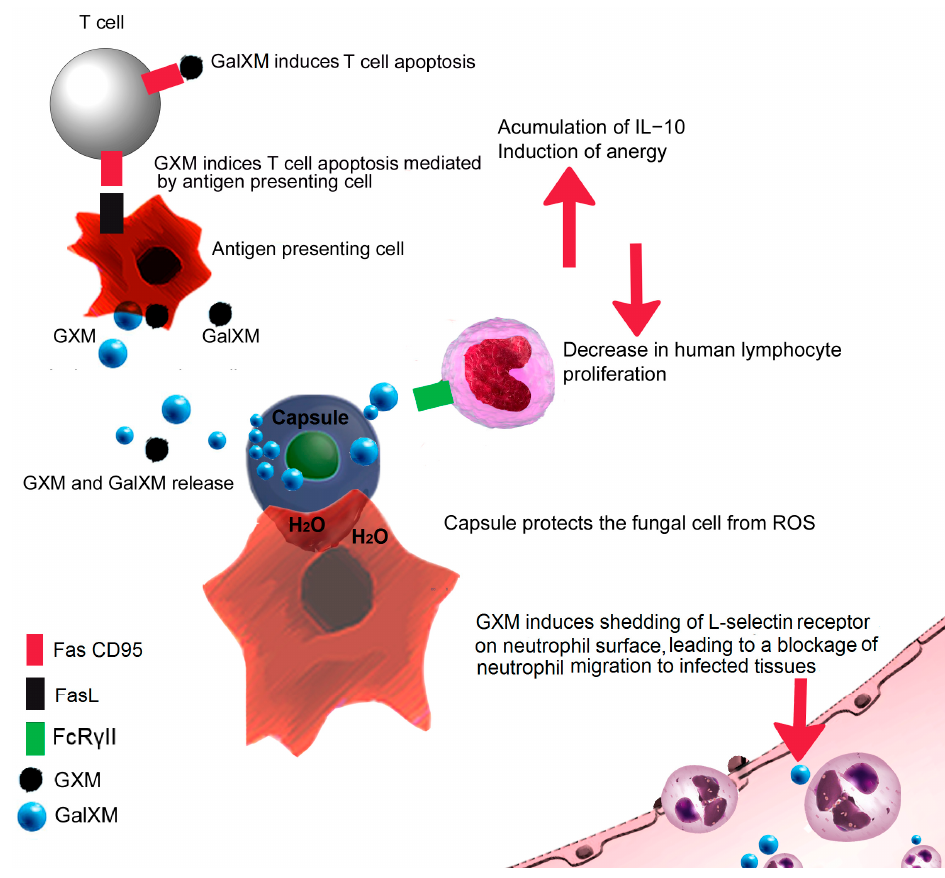
Figure 2. Mechanisms whereby the Cryptococcus neoformans capsule subverts the immune system. Capsule components are released into the extracellular space and directly induce T-cell apoptosis or cell death mediated by antigen presenting cells. Capsule components also decrease human lymphocyte proliferation and induce shedding of L -selectin and TNF α receptor on the surface of neutrophils, blocking their attachment to the endothelial surface and, therefore, migration to infected tissue is reduced. Once C. neoformans is phagocytosed, capsule enlargement occurs and protects the fungal cell from ROS-mediated killing.